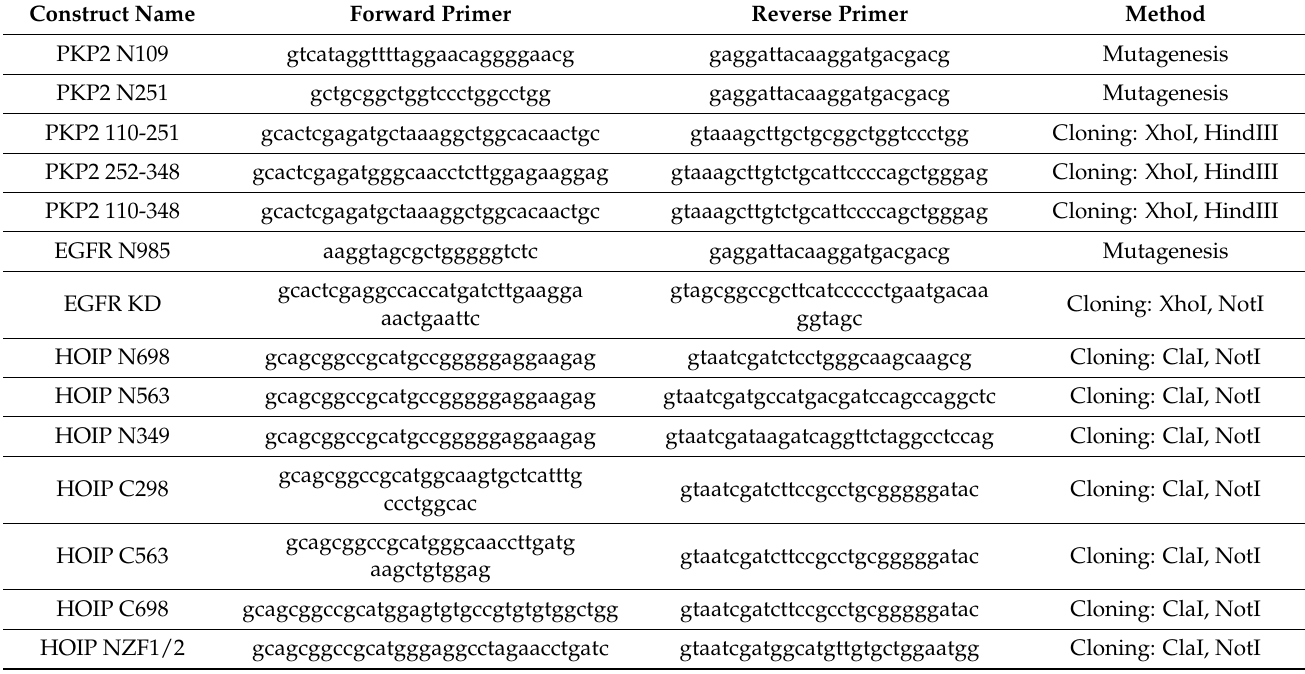
Table 1. PCR primers used for